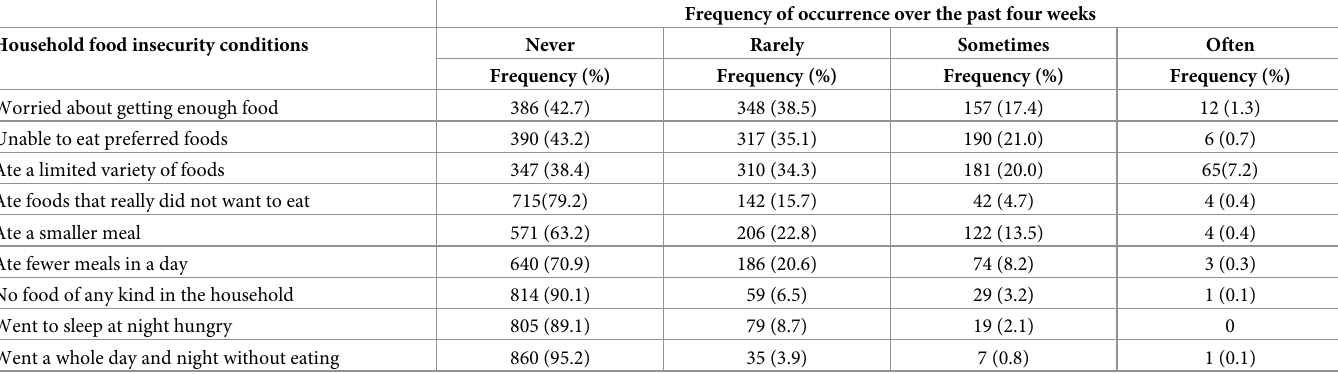
Table 4. Households’ experience and frequency of occurrence of food insecurity conditions in Dale district, Ethiopia, 2018, during the past four weeks (n = 903).